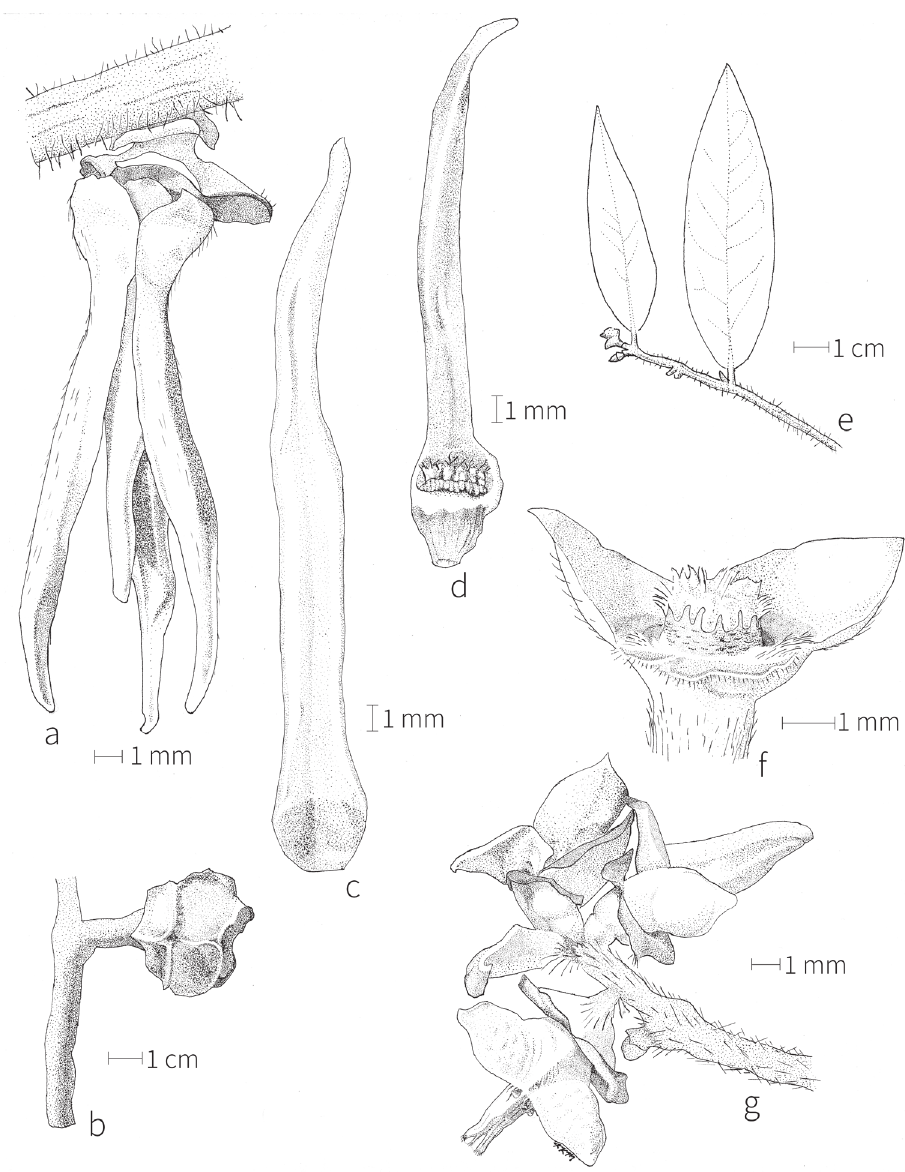
Figure 48. Xylopia villosa . A Flower, lateral view B Pedicel and torus of fruit C Outer petal, adaxial view D Inner petal, adaxial view E Shoot F Torus with sepals and staminal cone attached G Close-up of por- tion of inflorescence. A, C–G from Bernardi 8679 (A) B from Chevalier 22516 (P). outer staminodes 1.7–2.0 mm long, clavate, apex rounded; inner staminodes 0.8–1.1 mm long, oblong, apex truncate; staminal cone 1.6–2.0 mm in diameter, ca. 0.8 mm high, partially concealing the ovaries, rim laciniate. Carpels 10–12; ovaries 1–1.3